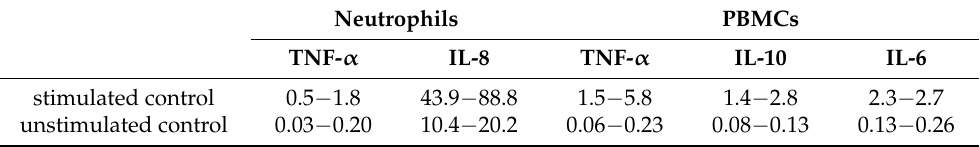
Table 4. Ranges of cytokine secretion levels (ng/mL) in stimulated and unstimulated